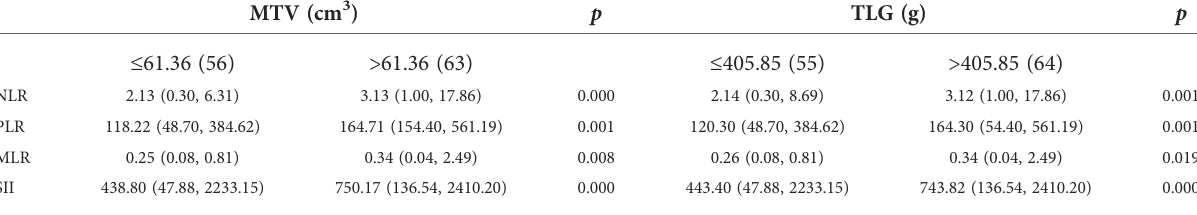
TABLE 4 Correlation of in fl ammatory markers with different MTV or TLG levels of SCLC.